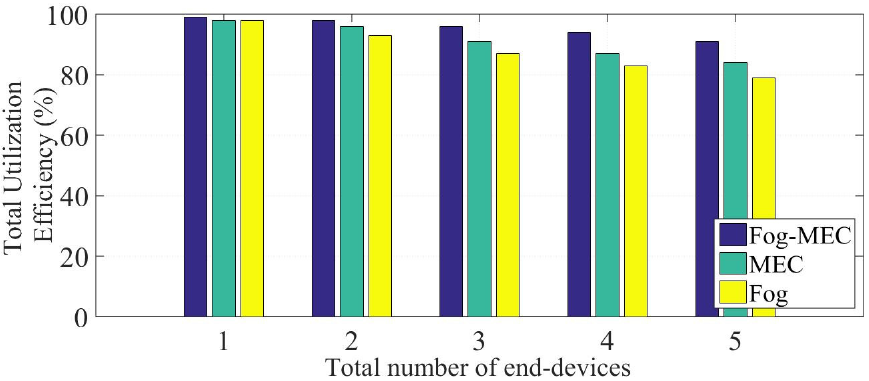
Figure 9. Total utilization efficiency of the proposed fog-MEC model compared to other existing systems.